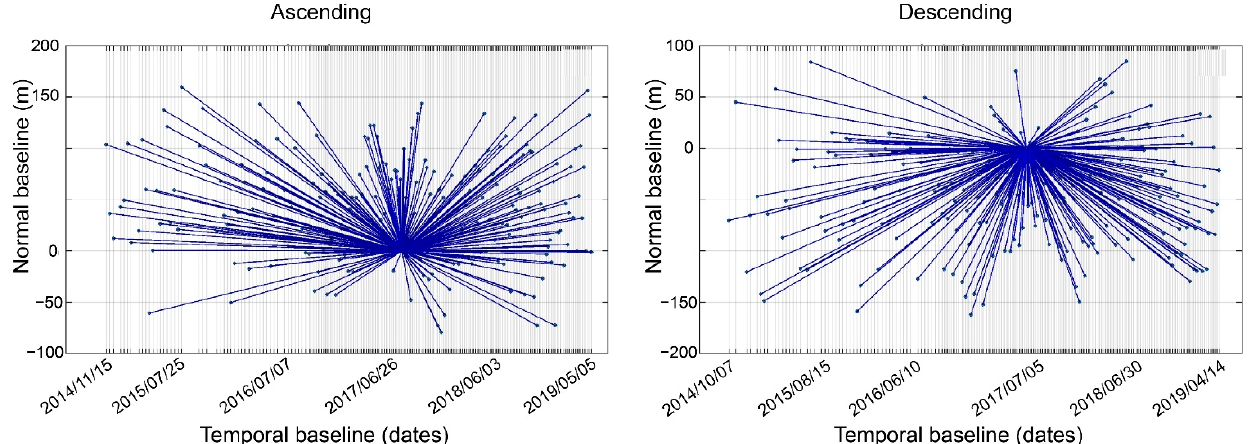
Figure 3. STAR graph generated by referring all images to a single master according to the temporal baseline (X axis) and normal baseline (Y axis) for ascending and descending orbital geometries. Every dot represents an image, whereas every line represents an interferogram.